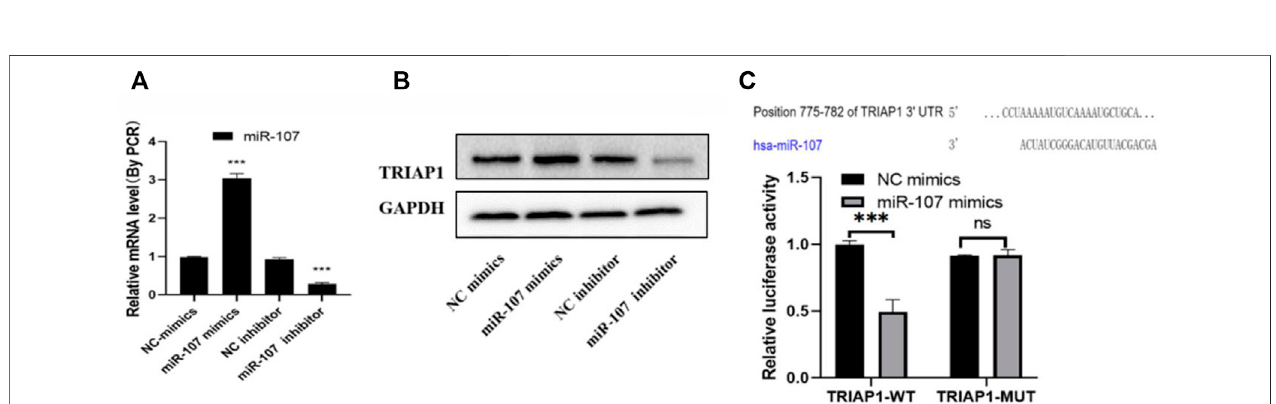
FIGURE 2 | miR-107 negatively regulates TRIAP1 expression (A) The expression level of miR-107 was detected by RT-PCR after different transfections, (B) The protein level of TRIAP1 was detected by Western blot after different transfections, (C) The luciferase activity was detected by dual luciferase reporter gene after different transfections. The data is expressed as the mean ± SD of three experiments, and the data is analyzed by Student t or ANOVA test, * p ＜ 0.05,** p ＜ 0.01,*** p ＜ 0.001.